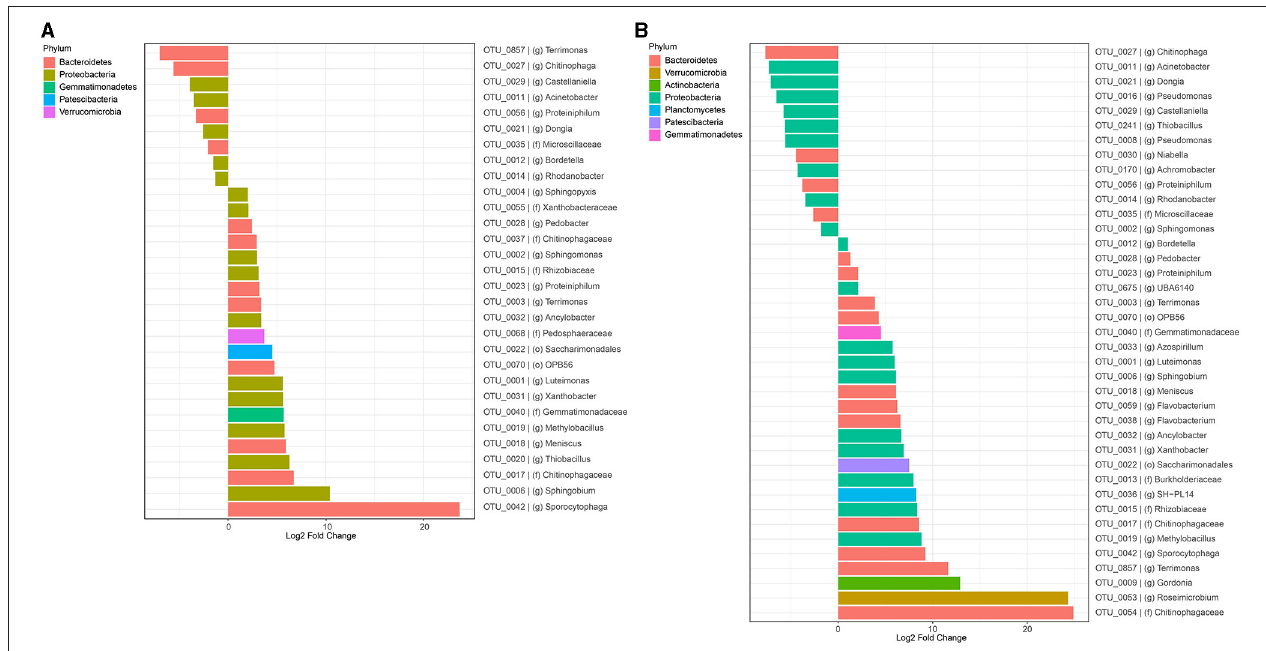
FIGURE 5 | Differential analysis representing each OTU whose relative abundance changed significantly ( p < 0.01) over time from the original inoculum (EPA), in 1st enrichment of T1 soil communities with 2,4-D and 2,4,5-T in powder form (A) and 2,4-D and 2,4,5-T dissolved in acetone (B) . Colors represent the phylum of the presented OTUs.